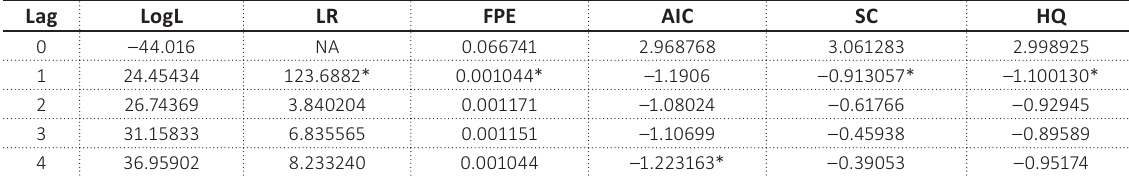
Table 2. VAR Lag order selection